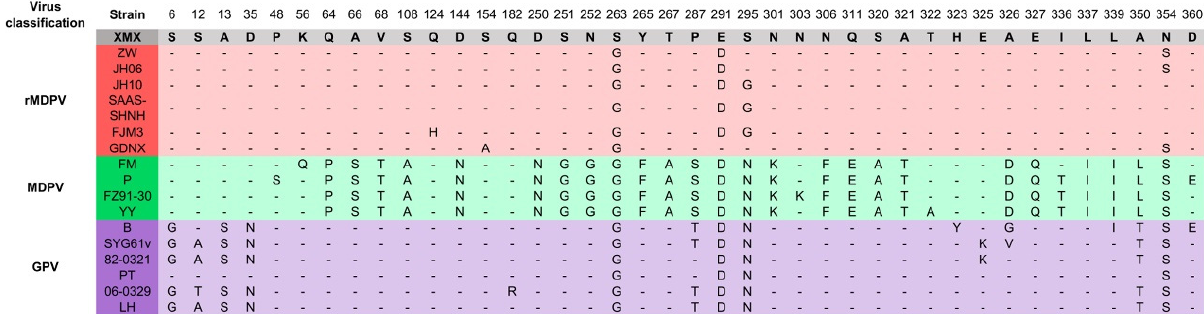
Figure 6. Alignment of amino acid residues of VP3 protein. Only the differentiated amino acid residues are shown.